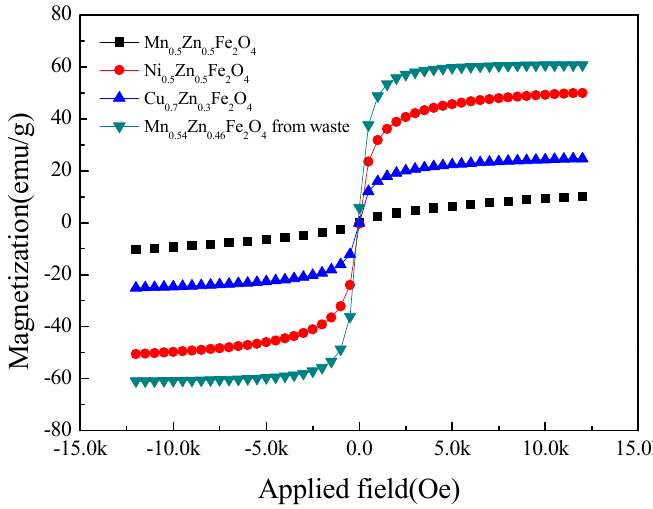
Figure 3. The hysteresis curves for different compositions and proportions; [M x Zn 1 − x ]Fe 2 O 4 (M = Mn, Zn, Cu).